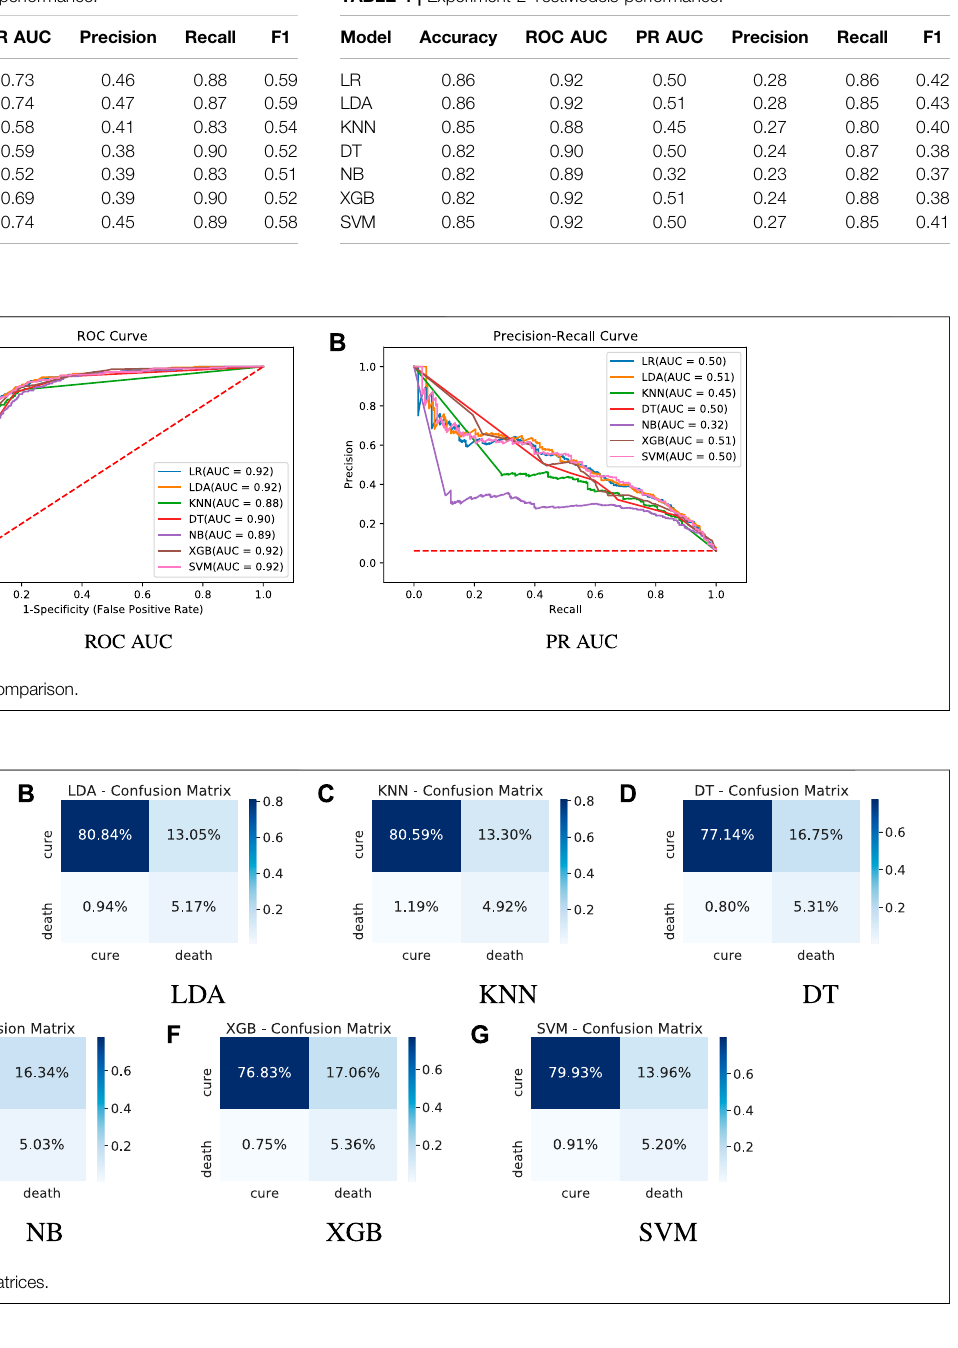
TABLE 4 | Experiment 2 TestModels